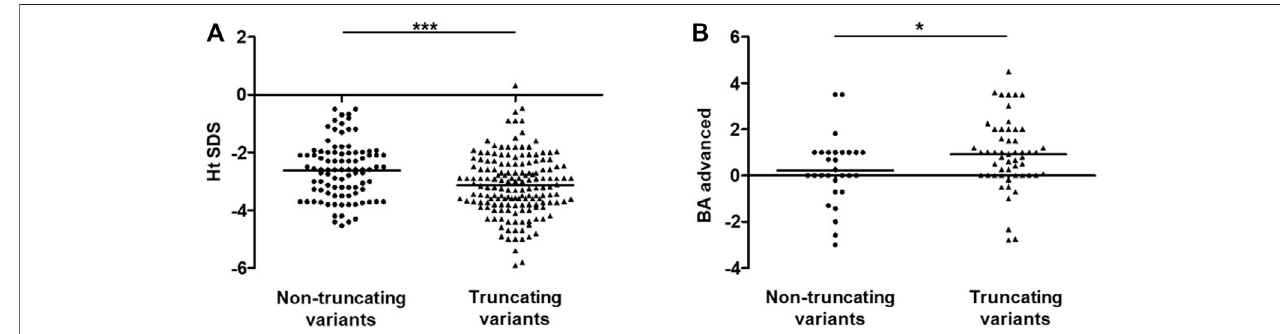
FIGURE 3 | Analysis of Ht SDS and BA-CA between non-truncating variants and truncating variants groups in SSOAOD patients. (A) Comparison of Ht SDS between non-truncating variants and truncating variants groups. (B) Comparison of BA-CA non-truncating variants and truncating variants groups. * p < 0.05, *** p < 0.001. Abbreviation: Ht SDS: height standard deviation, BA: bone age, CA: chronological age; truncating mutations: frameshift mutations, nonsense mutation, synonymous mutations, splicing mutation, exon deletion; non-truncating mutations: missense mutations, small